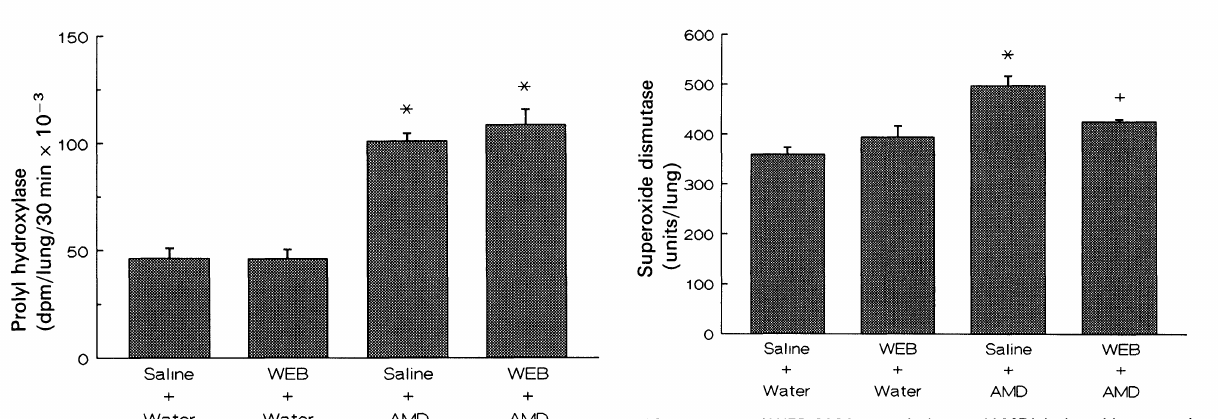
FIG. 5. Effects of WEB 2086 on amiodarone (AMD) induced increases in superoxide dismutase activity of hamster lung. See the legend to Fig. for treatment details. Each value represents the mean -I-S.E.M. of eight hamsters in each group. Significantly higher (p _< 0.05) than all other groups, Significantly higher (p _< 0.05) than saline + water group but not WEB + water group.